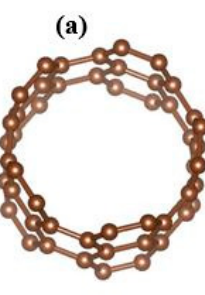
Figure 1. Hybrid SWCBNNT hetero-nanotubes optimized by inter-tube coupling. ( a ) Metallic (5, 5) SWCNT ( b ) Non-metallic (5, 5) SWBNNT and ( c ) Semi-conducting (5, 5) SWCBNNT.